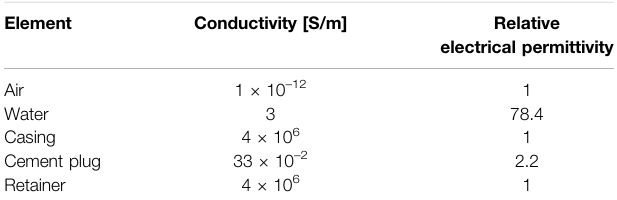
TABLE 3 | Properties of conductivity and relative electrical permittivity of the main elements of the well.